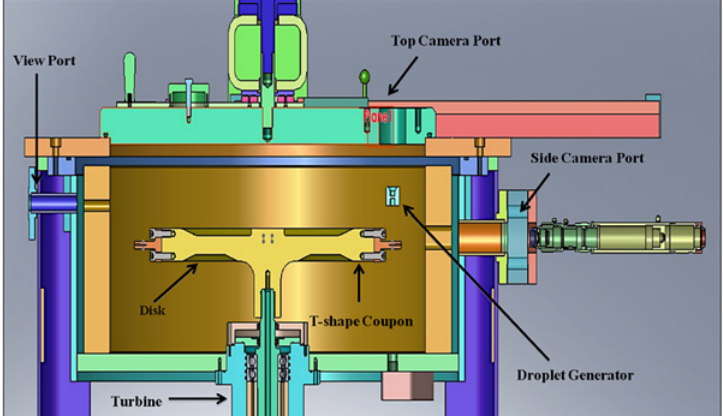
Figure 3. Schematic illustration of the water erosion rig.